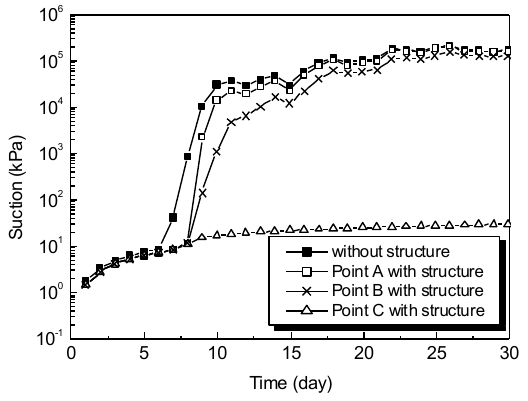
Figure 9a. Influence of the presence of the structure on the variation of soil suction.